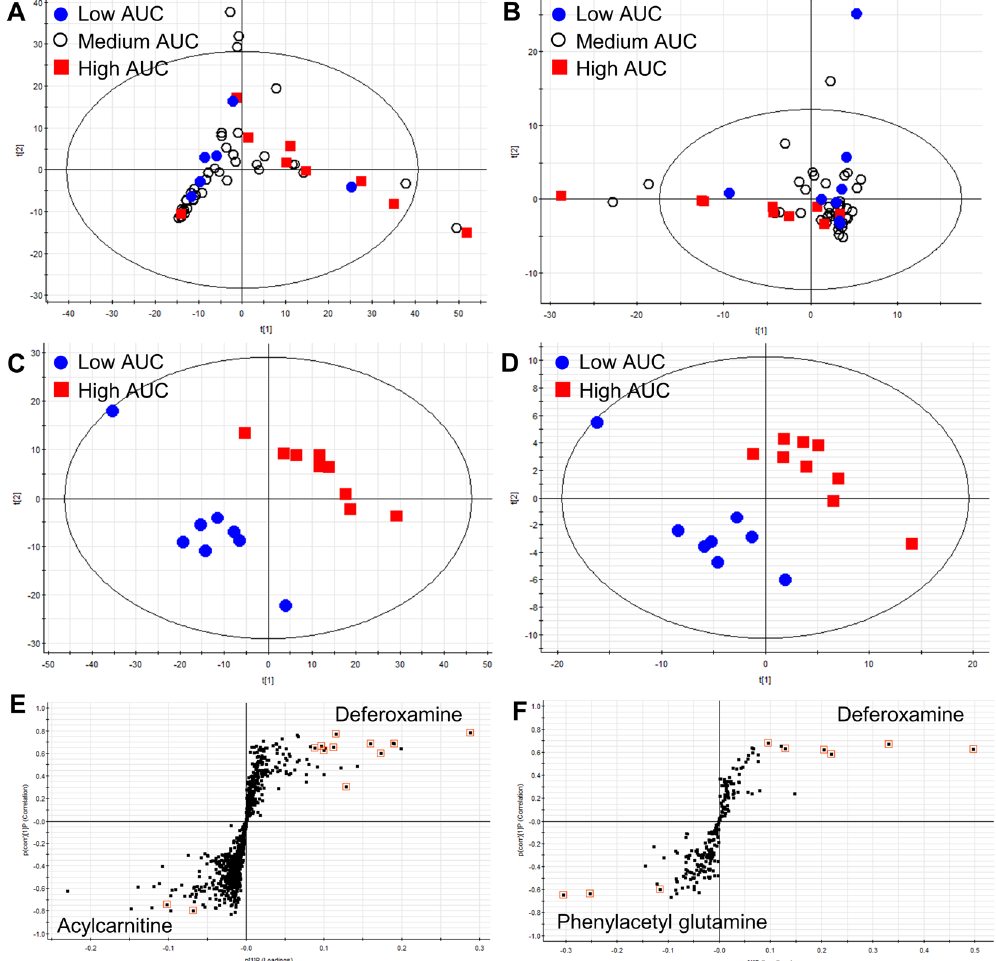
Figure 2. Sixteen deferoxamine-derived metabolites, two acylcarnitines, and phenylacetylglutamine were identified by pharmacometabolomics and significantly associated with high exposure to busulfan. Two dimensional unsupervised principle component analyses in ( A ) positive and ( B ) negative ion mode were conducted. Supervised partial least-squares to latent structure discriminant analysis (PLS-DA) of ( C ) positive and ( D ) negative ion mode, and the orthogonal PLS-DA following S-plot of ( E ) positive and ( F ) negative ion mode illustrated the putative metabolites responsible for discrimination of the low-AUC group from the high- AUC